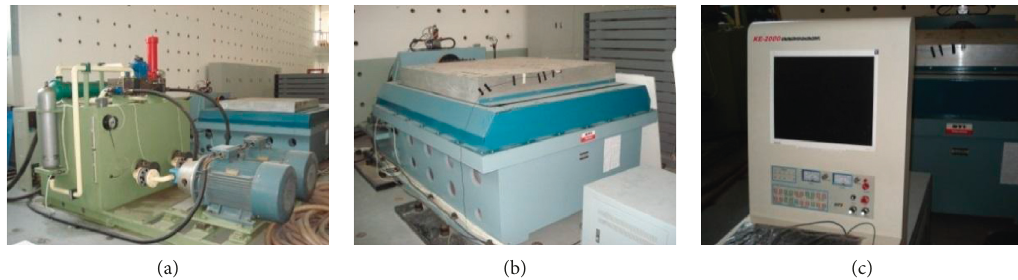
Figure 21: Shaking table test equipment. (a) Hydraulic system. (b) Shaking table. (c) Vibration controller.